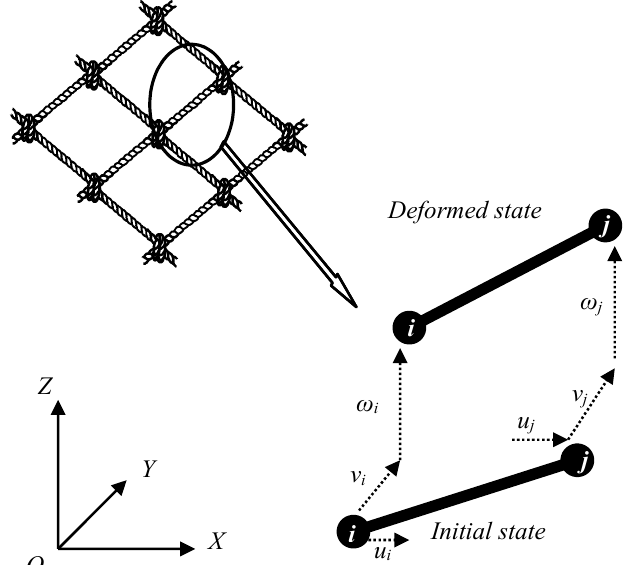
Figure 2. Diagram of the element motion. X , Y , and Z , are the global system coordinates; u , v , and ω , denote the nodal displacements of an element in the direction of X , Y , and Z axes; and i and j indicate the ends of the element, respectively.